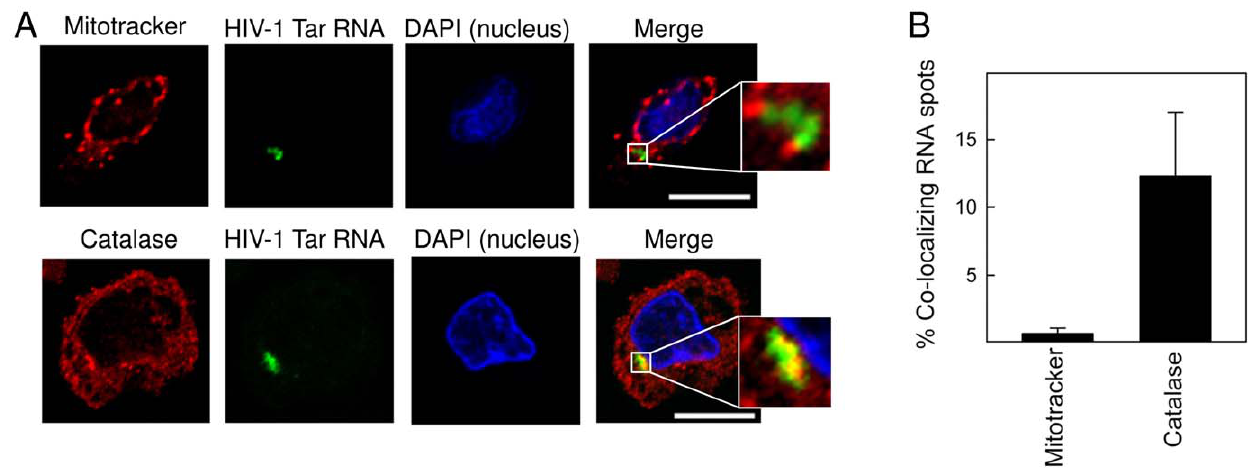
Figure 4. HIV Tar co-localizes with peroxisomes but not with mitochondria. PBMCs stimulated with 1.2 m g/ml FAM-labeled HIV-Tar RNA (green) for 180 min were labeled for mitochondria (red) or peroxisomes (red). Nuclei were stained with DAPI (blue). Co-localization is shown in yellow, scale bar 20 m m. Representative images are shown in A, while panel B shows a quantification of percentage RNA-organelle co-localization as obtained by counting more than 100 cells per group. Similar results were obtained in two independent experiments.